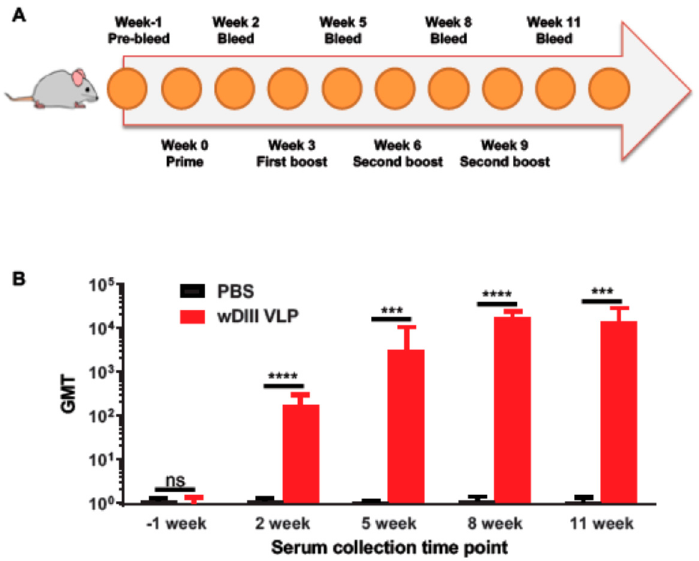
Figure 5. Antibody responses after subcutaneous immunization of HBcAg-wDIII. ( A ) Scheme of immunization. BALB/C mice were immunized on weeks 0, 3, 6, and 9. Blood samples were collected on the indicated weeks. ( B ) Antibody responses in sera of immunized mice. Serum wDIII-specific IgG was measured by ELISA. The y-axis shows the geometric mean titers (GMT) and the error bars show the 95% level of confidence of the mean. NS, ***, and **** indicate p values >0.05, <0.001, and <0.0001, respectively, of HBcAg-wDIII VLP-immunized serum compared to that of negative control serum from PBS-injected mice.